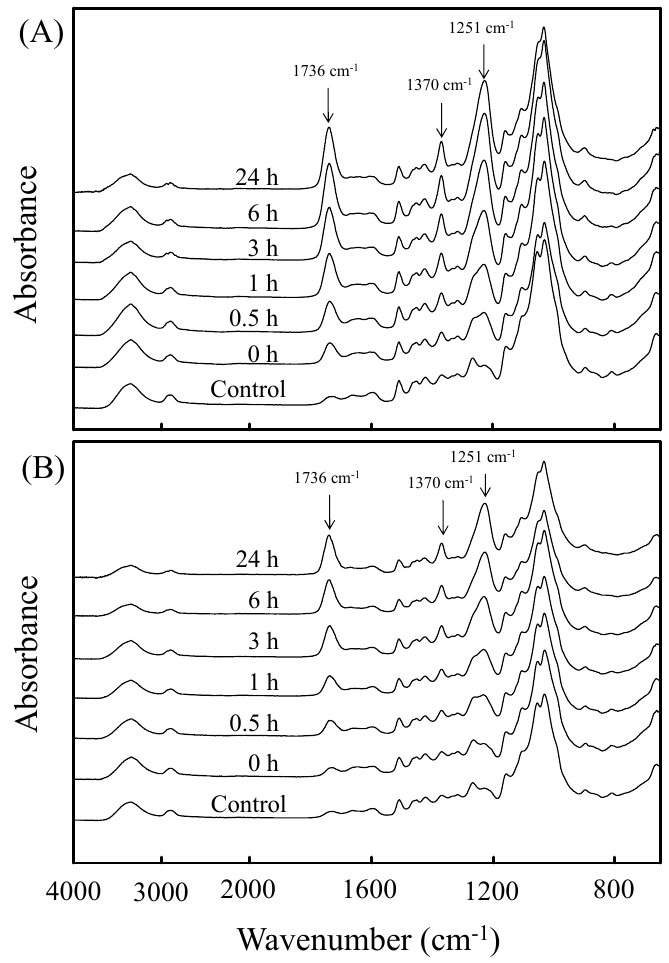
Figure 2. The attenuated total reflectance Fourier transform infrared (ATR-FTIR) spectra of VA-acetylated slicewood with potassium carbonate (PC) ( A ) and potassium acetate (PA) ( B ) as a catalyst at various reaction time.